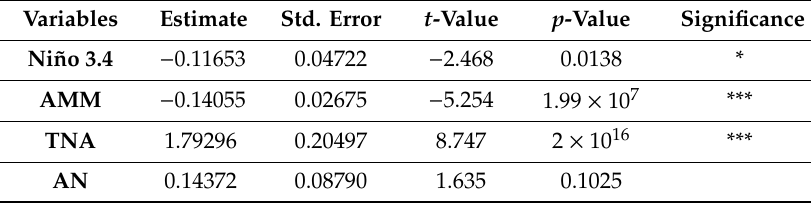
Table 1. The output of Multiple Linear Regression (MLR) model in which temperature is a dependent variable and AMM, Niño3.4, TNA and AN are independent variables.